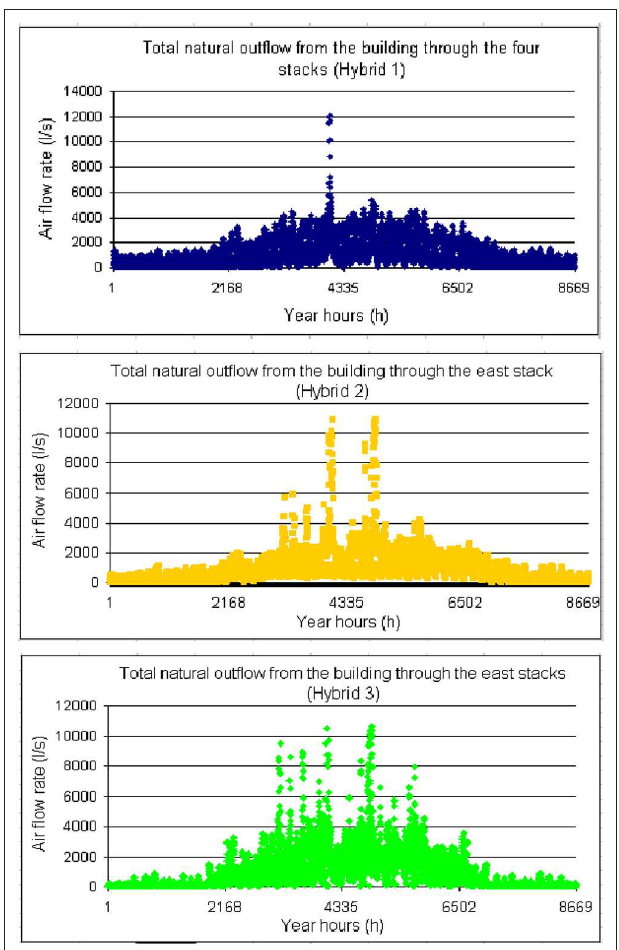
FIGURE 11 | Total outflow from the building through the east Stack for the proposed hybrid ventilation strategies.